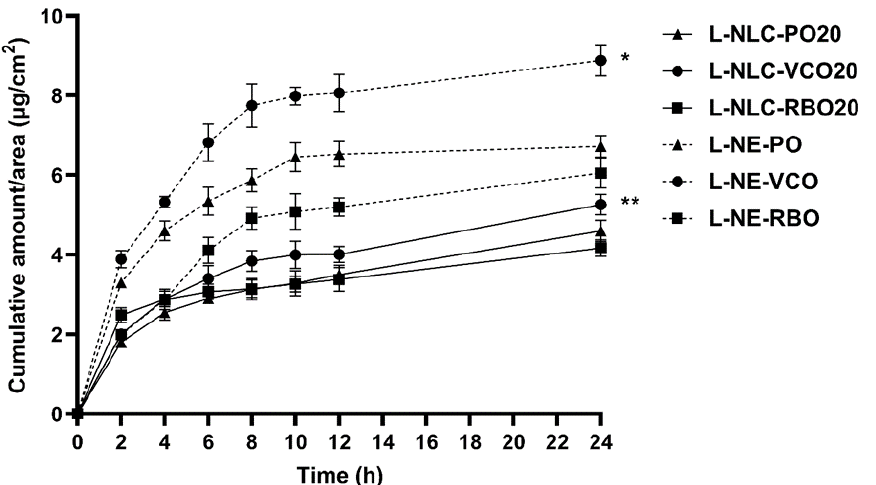
Figure 7. In vitro release profiles of lutein-loaded lipid nanoparticles ( n = 3). * Statistically significant difference comparing the cumulative amount of lutein release per area at 24 h among all NE formulations (L-NE-VCO, L-NE-PO and L-NE-RBO) ( p < 0.05). ** Statistically significant difference comparing the cumulative amount of lutein release per area at 24 h among all NLC formulations (L-NLC-VCO20, L-NLC-PO20 and L-NLC-RBO20) ( p < 0.05).